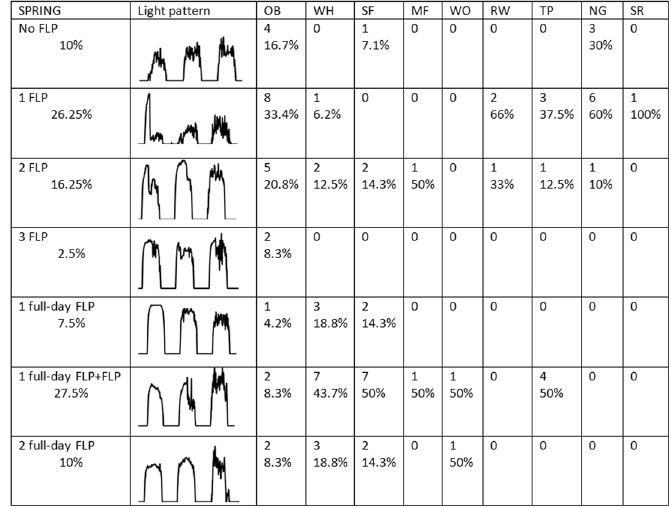
Figure 4. Detailed spring overview of daytime light pattern anomalies (FLP) recorded by geolocators while birds were crossing a desert. Each category is accompanied by a representative figure of recorded light intensities, numbers of individuals and species-specific % of occurrence, in line with previous publications 9 . OB: ortolan bunting, WH: whinchat, SF: spotted flycatcher, MF: Mediterranean flycatcher, WO: wood warbler, RW: Eurasian reed warbler, TP: tree pipit, NG: nightingale, SR: rufous-tailed scrub-robin. The first four categories totalize 55% of tracked individuals (stopovers in the desert), the last three categories 45% (probable non-stop flight over the desert) – see Fig. 3 for the description and interpretation of light